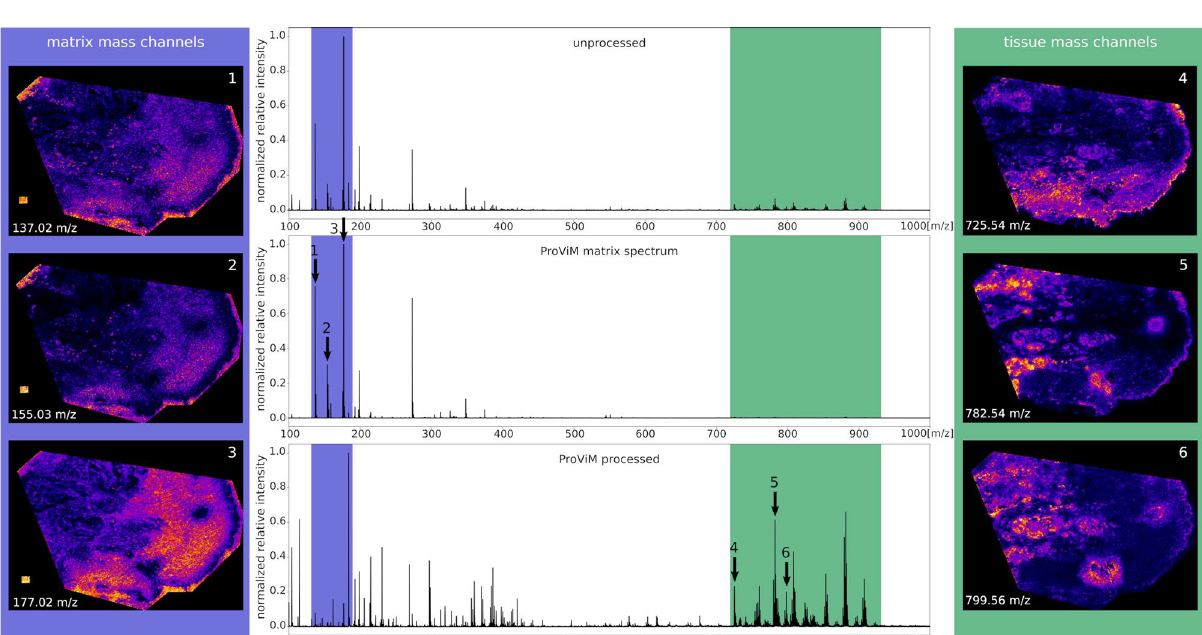
Figure 3. Result of the matrix signal subtraction step: Three average mass spectra normalized to [0,1] of the t human PXE skin data set ( I s ) measured with DHB matrix and MALDI-ToF are shown in the center column. The topmost mass spectrum shows the average spectrum before matrix subtraction. The middle MS is the approximate average spectrum of the matrix pixels manually selected in the matrix subtraction tool of ProViM. The main matrix mass range is highlighted with a blue box. Three representative mass channels are marked with arrows and their corresponding single mass channel images with matrix specific distributions are shown in the left column. The lowest MS shows the overall average spectrum after matrix subtraction with ProViM. The lipid region is highlighted with a green box and three representative mass channels are marked with arrows. The corresponding mass channel images with tissue-specific distributions are shown in the right column. ProViM matrix subtraction substantially enhances the mass signals of the lipid region of